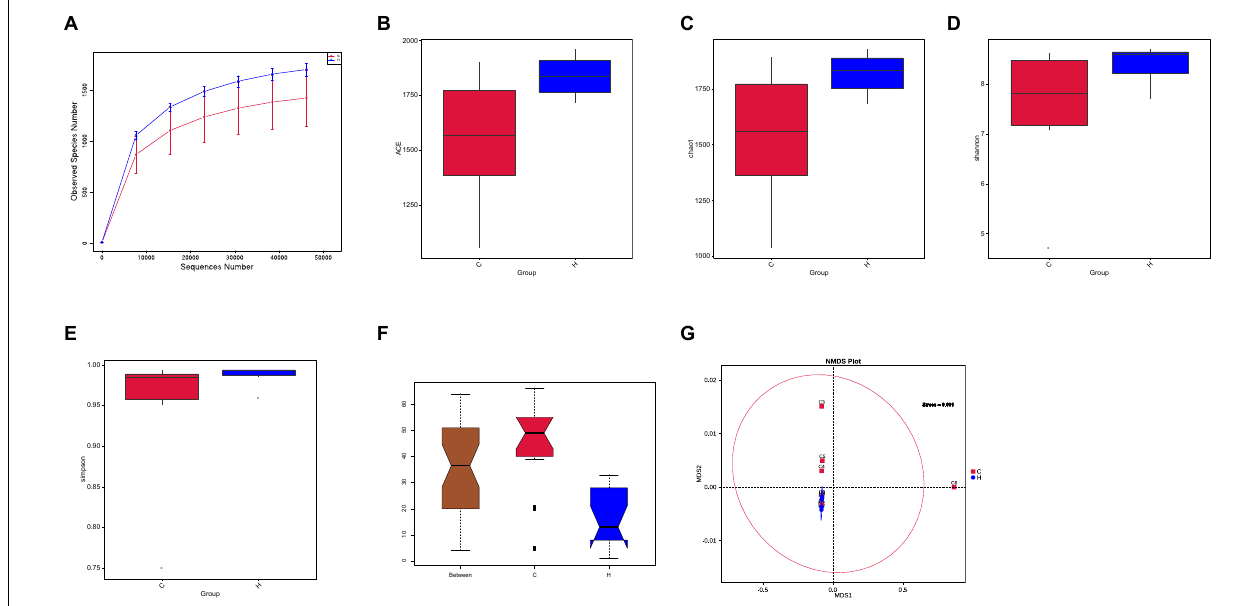
FIGURE 2 | Effects of HS on the fecal microbiota of rabbits. (A) Rarefaction curves (the mean curves for the samples/group) were used to plot the number of phylotypes detected in the 16S rDNA gene libraries by the number of sequences from the fecal microbiota of rabbits in the HS and CON groups. (B) Box chart of ACE index difference between the HS and CON groups. (C) Box chart of Chao index difference between the HS and CON groups. (D) Box chart of Shannon index difference between the HS and CON groups. (E) Box chart of Simpson index difference between the HS and CON groups. (F) Rank significance test of the fecal community between the HS and CON groups based on the Bray–Curtis distance metric (ANOSIM analysis). R -value > 0, the difference between the groups was significant (G) . Non-Metric Multi-Dimensional Scaling (NMDS) ordination plots of the fecal bacterial communities in the HS and CON groups based on the Bray–Curtis distance metric. HS, heat stress; CON,